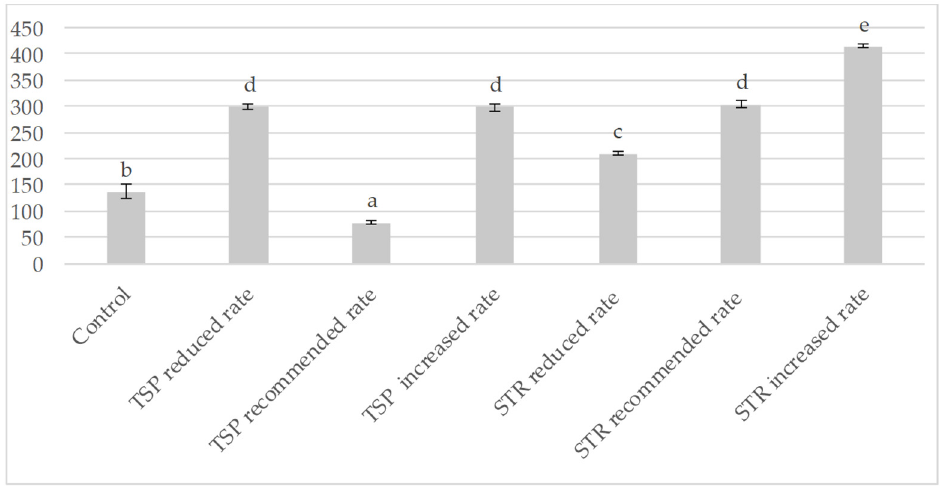
Figure 5. Nitrate nitrogen content in butterhead lettuce leaves (mg kg − 1 DM) as affected by the interaction of examined factors (A × B) at the level of significance α = 0.05 ( p value < 0.001).